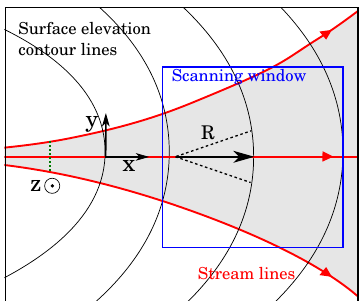
Figure 1. The x axis is taken along the ridge stream line, and the y axis tangent to the surface elevation contour. The scanning win- dow is used to determine the value of R in its centre. Lateral stream lines are represented to show the non-linear widening of the flow tube in this particular case, and the corresponding accumulation sur- face is coloured in